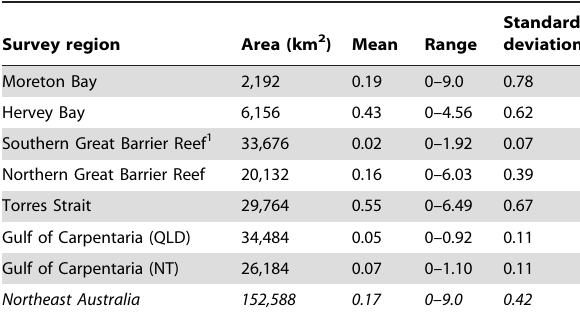
Table 2. Mean, range and standard deviation of the relative density estimates (dugongs/km 2 ) within the seven survey